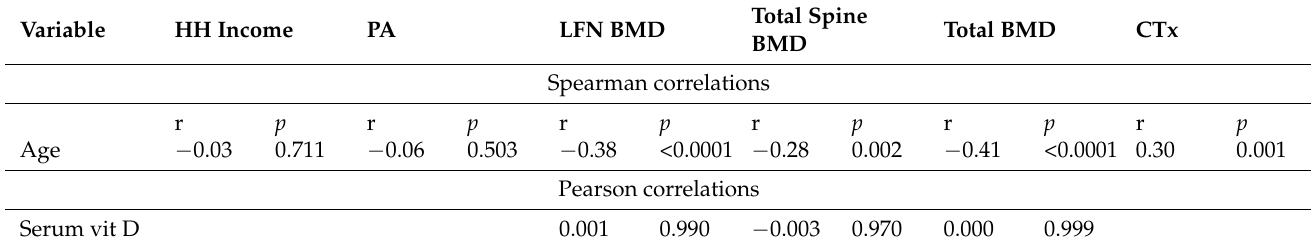
Table 2. Spearman and Pearson correlations between age and lifestyle and bone